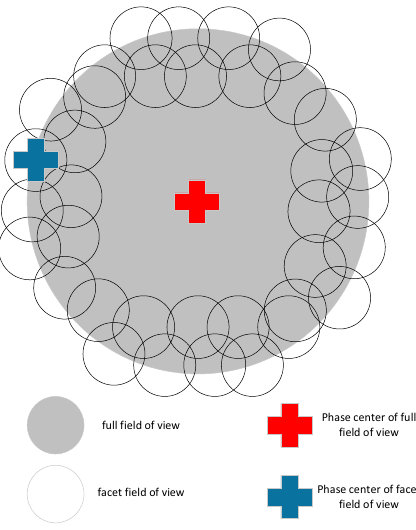
Figure 1. The principle of facet split for facet imaging.